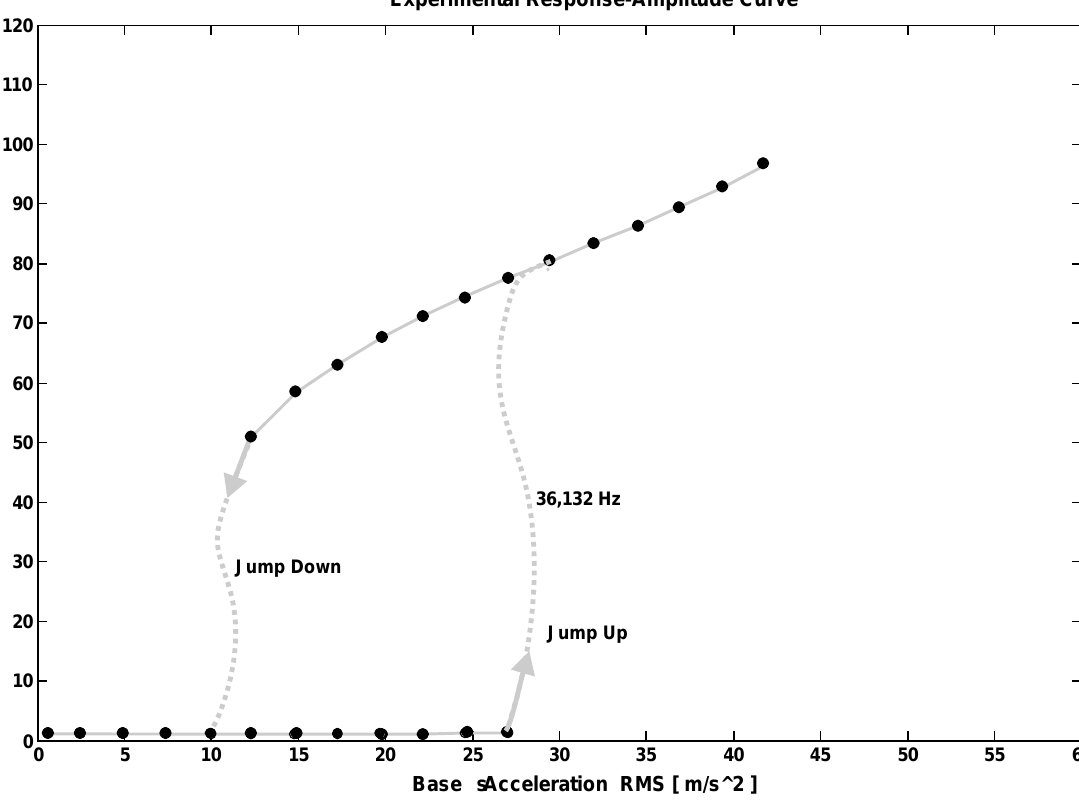
Fig. 12. Experimentally determined response-amplitude curve without the presence of external excitation for principal parametric resonance